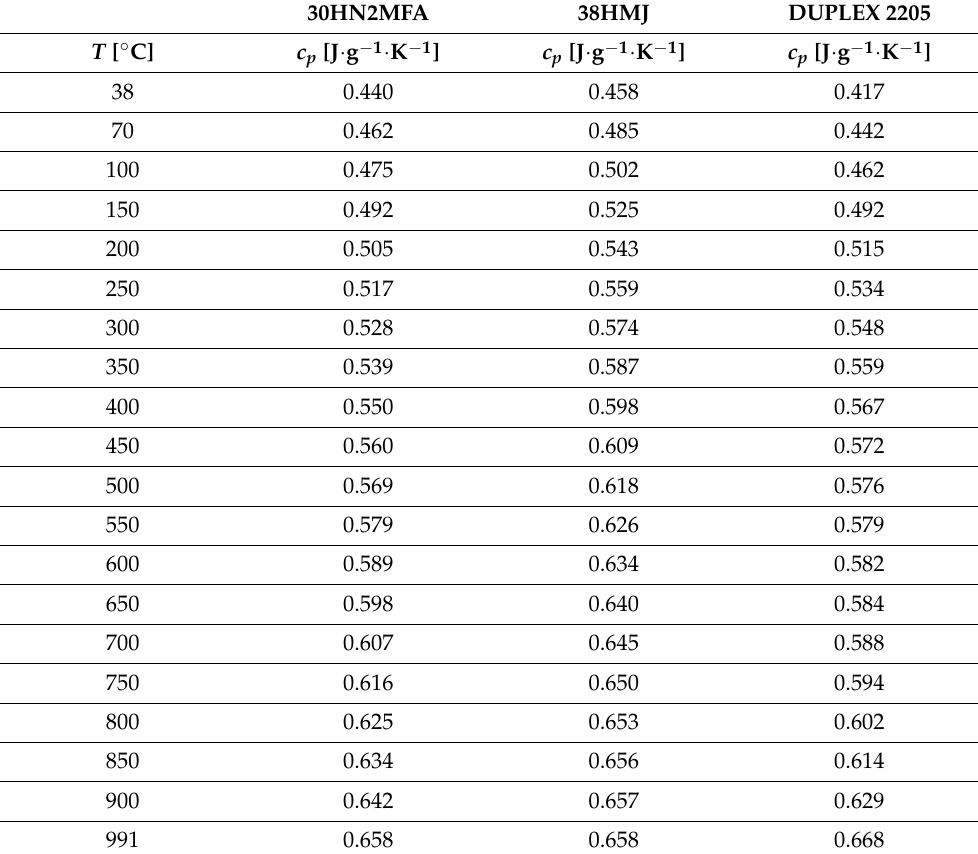
Table 3. Data on apparent specific heat of selected barrel steels [12].